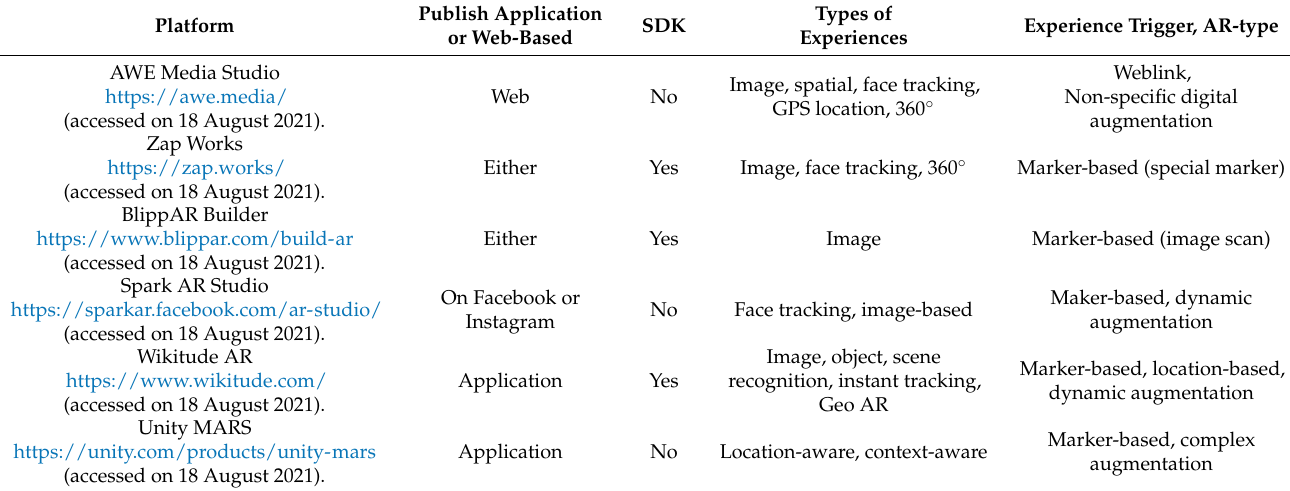
Table 4. Comparison of AR platforms with types and